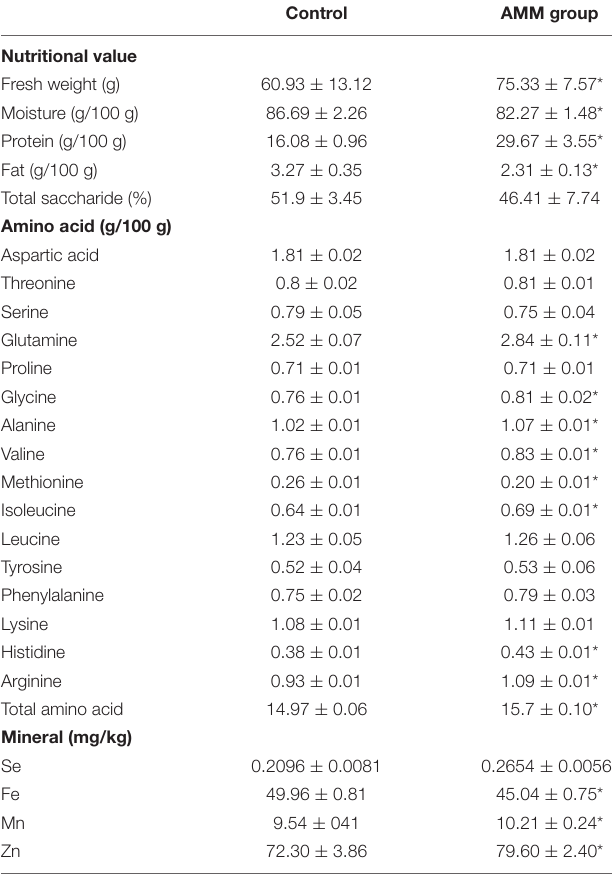
TABLE 1 | Nutritional value, amino acid content and elemental concentrations of P. ostreatus var. florida (mean ±